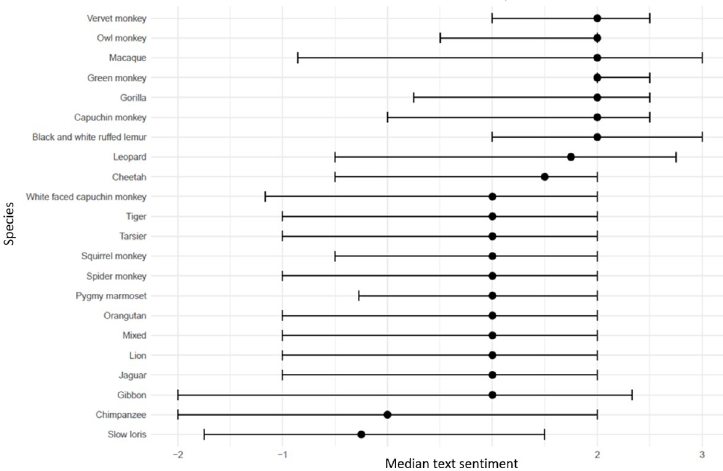
Fig 2. Median text sentiment of 346 YouTube 1 videos published between 2006 and 2019 associated with search terms explored, wherein key exotic wild cat (a, n = 203) and primate (b, n = 143) species were identified. Error bars represent first to third